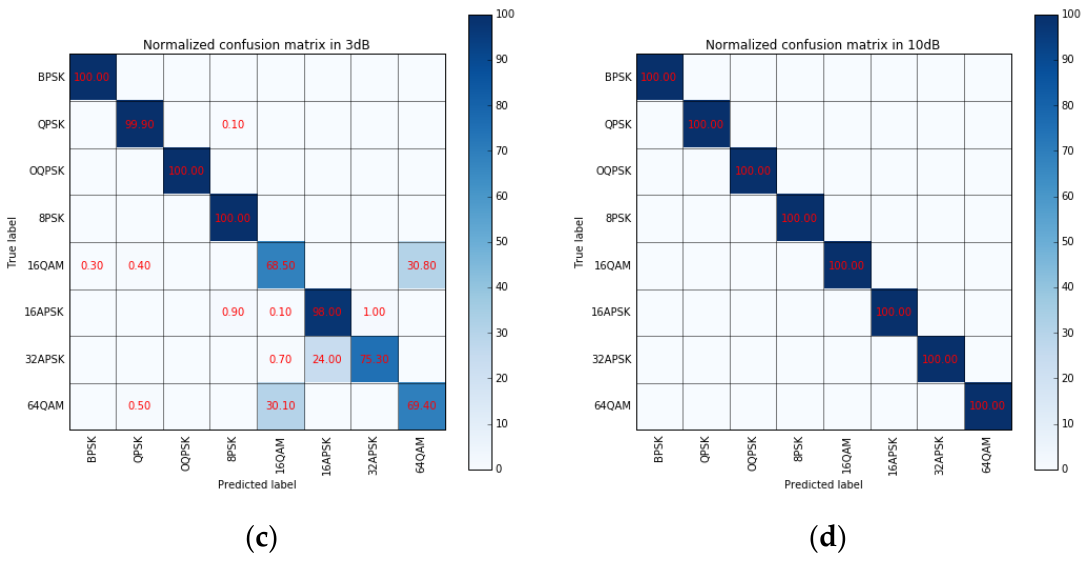
Figure 13. The performance of each modulation ( a ) classification accuracy for each modulation versus SNR; ( b ) normalized confusion matrix in 0 dB; ( c ) normalized confusion matrix in 3 dB; ( d ) normalized confusion matrix in 10 dB